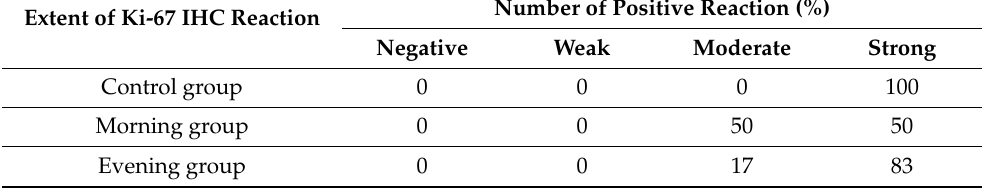
groups as compared with vehicle-treated animals (Figure